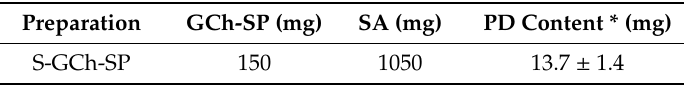
Table 2. Preparation condition and drug content of